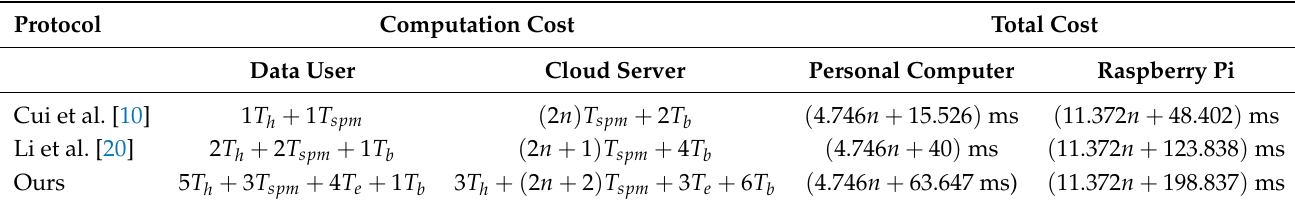
Table 4. Comparison of computation